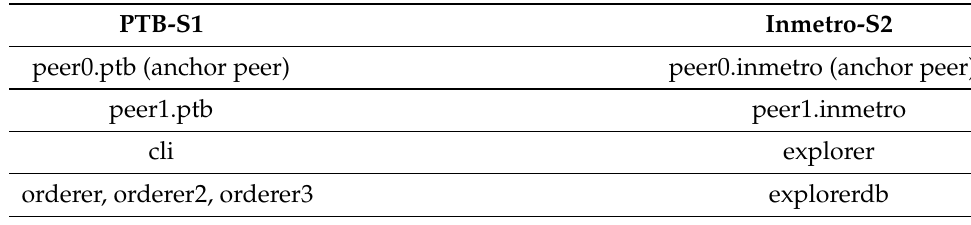
Table 2. Distribution of Docker containers.